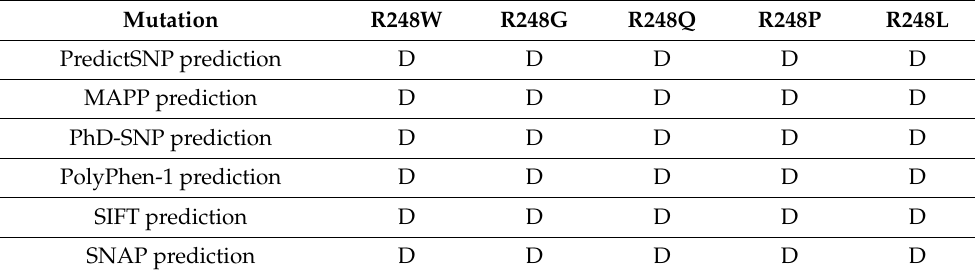
Table 1. List of deleterious p53 R248 missense mutations predicted by PredictSNP server.